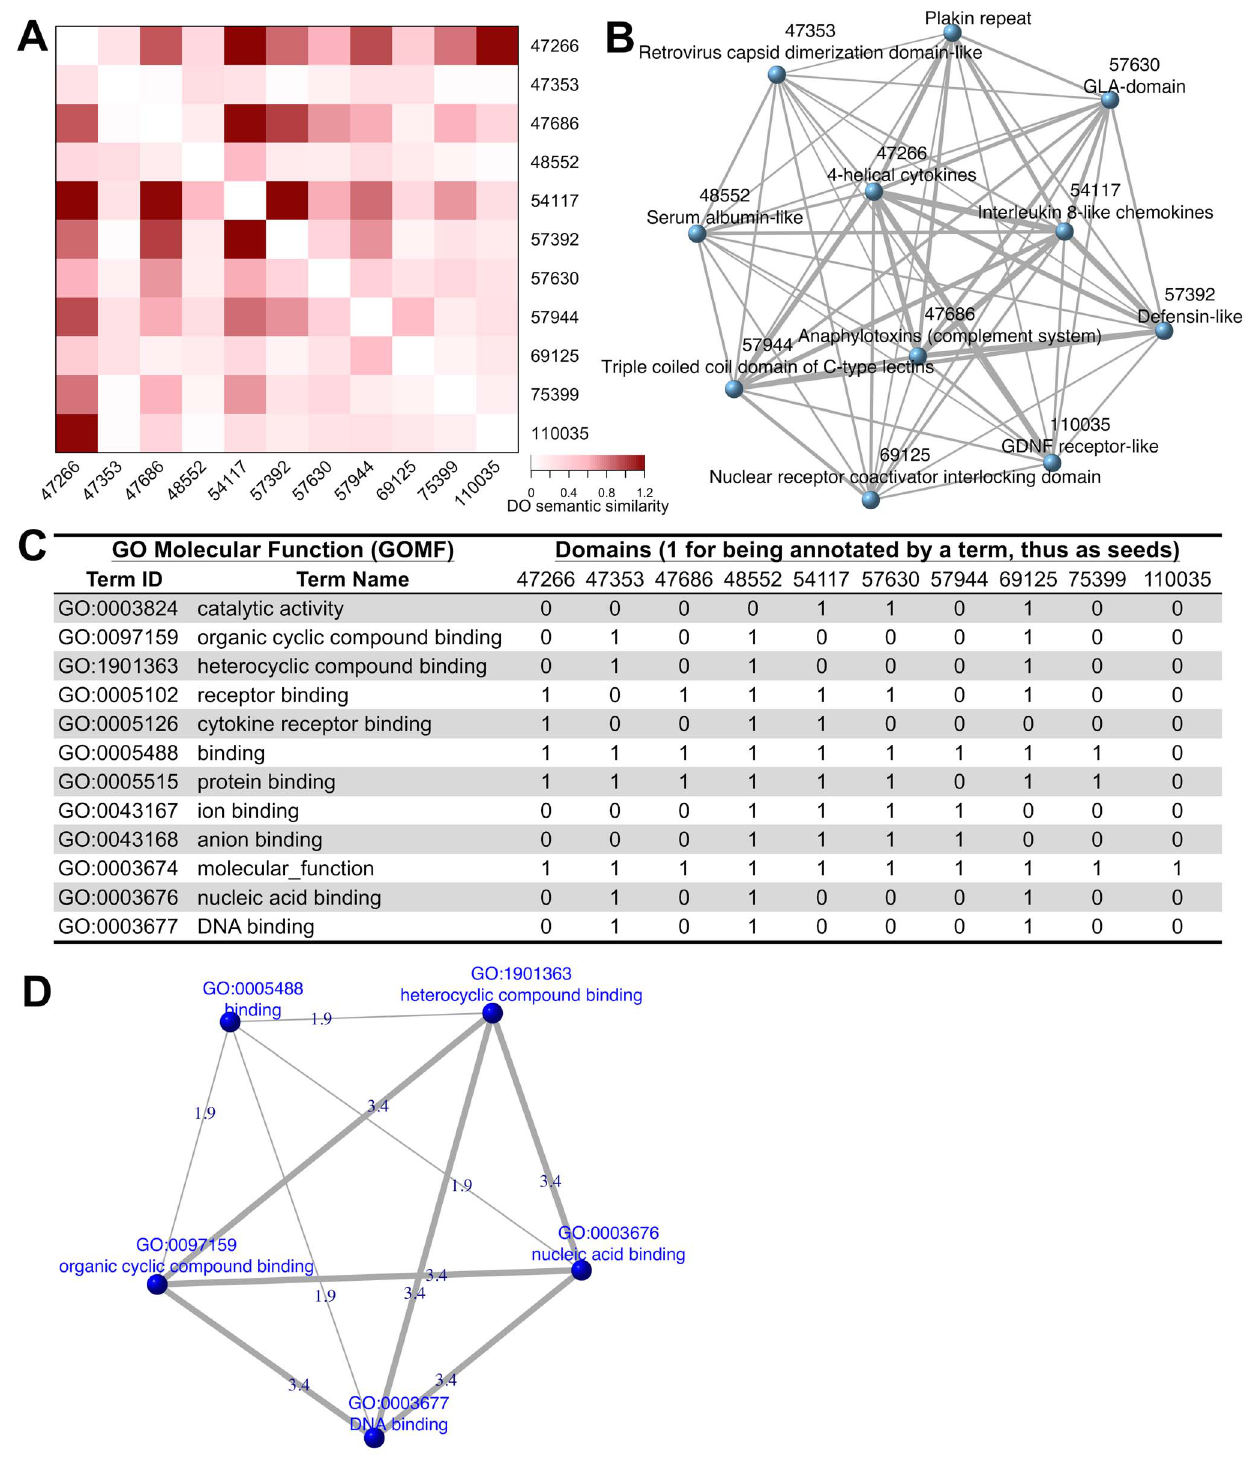
Figure 2. In-depth analysis for network-level understanding. ( A ) Heatmap visualisation of the semantic similarity between pairs of domains according to their annotations by Disease Ontology (DO). ( B ) Network representation of the pairwise domain semantic similarity. It is a weighted and undirected network, with edge thickness indicating semantic similarity between a pair of domains/nodes. Nodes are labeled by both numeric id and textual description. ( C ) A table listing GOMF terms and their annotated domains (used as domain seeds for random walk with restart, RWR). Notably, terms used here are only those with at least 3 annotatable domains that are also in the domain network (see Figure 2B). ( D ) Contact (statistical significance) network between GOMF terms in Figure 2C, as estimated by RWR on the domain network in Figure 2B. Only those significant contacts/ edges (adjusted p-values , 0.1) are shown, with thickness indicating the contact strength (z-score).